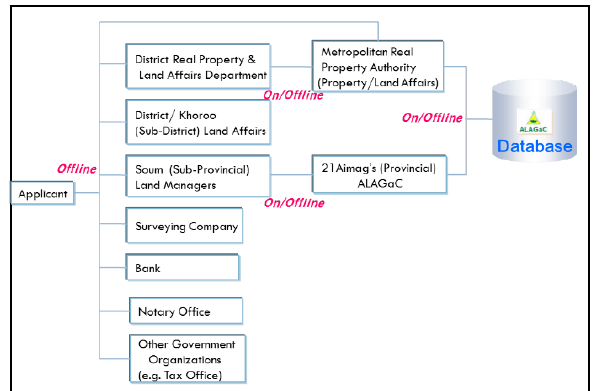
Figure 3. Current institutional structure in cadastral